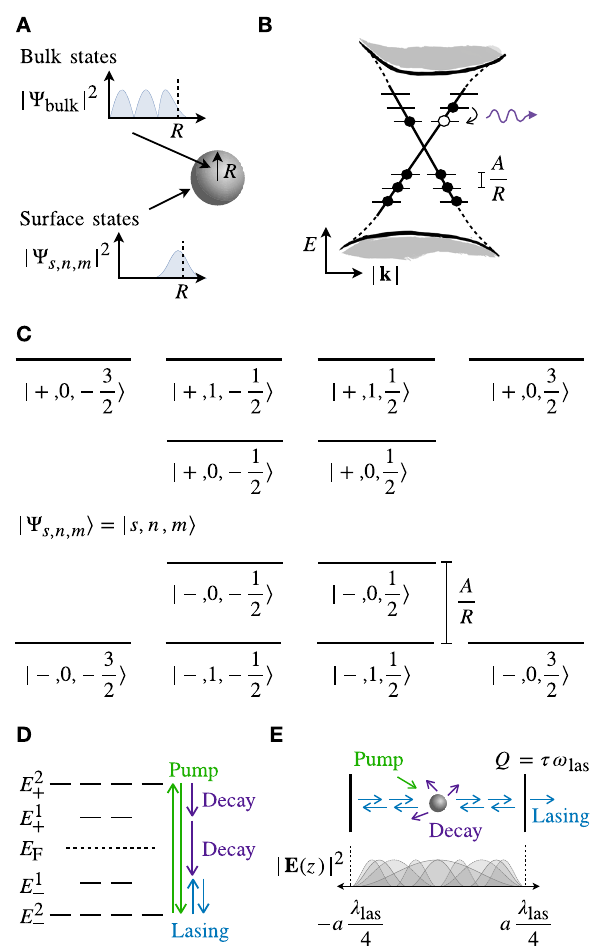
Figure 1: Lasing topological quantum dots: (A) schematic of topological quantum dot, showing bulk and surface states. (B) Discretization of Dirac cone for small nanoparticles, with energy level separation near the Dirac point inversely proportional to particle radius, R and directly proportional to material-dependent constant A . Transitions between energy levels are facilitated by the absorption or emission of THz light. (C) The discrete energy levels are labelled by three quantum numbers | s , n , m ⟩ . We present the labels for the four energy levels closest to the Dirac point. (D) Example lasing scheme with interband pumping and bottom-most = 0. (E) Schematic transition as the lasing transition. Fermi level E F ∕ 2 with a an integer, lasing frequency of TQD in cavity of length a 𝜆 las 𝜈 , quality factor Q = 𝜏𝜔 with 𝜏 the cavity lifetime. The c -axis of las las the material is aligned with the cavity axis. Spatial dependence of the cavity electric field gives spatial dependence of photonic DOS and consequently transition rates. TQD placed at centre of cavity for maximal interaction with the cavity field, meaning that only modes with a odd will have non-zero transition rates in the cavity